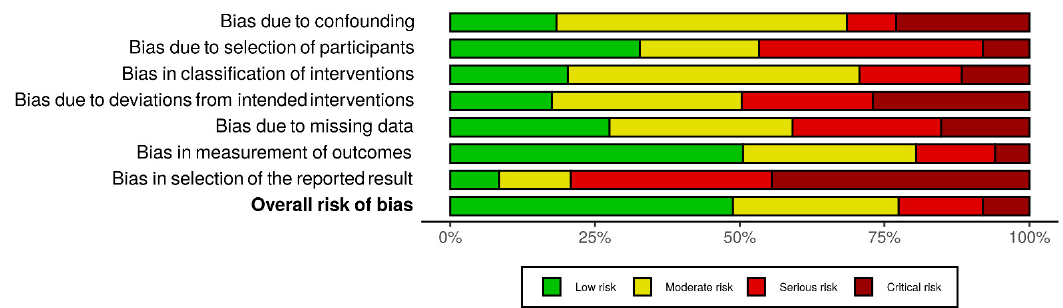
Figure 5. Weighted bar plot of the distribution of risk-of-bias judgements within each bias domain.